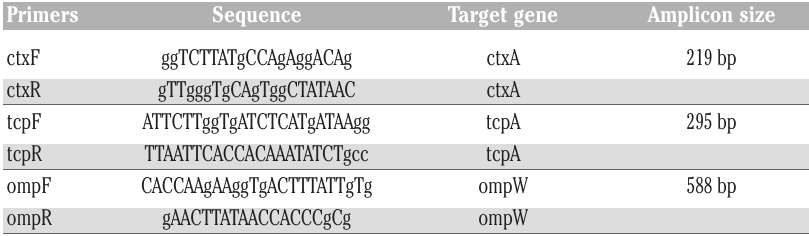
Table 1. Primer sequences used in this